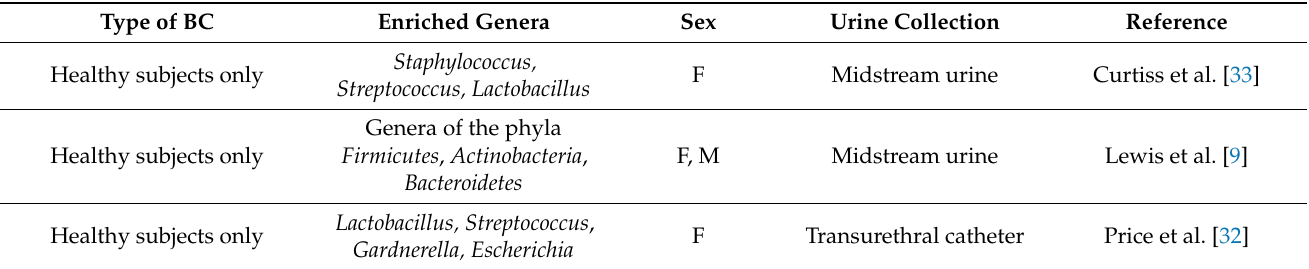
Table 1. Urinary microbiome in a healthy human